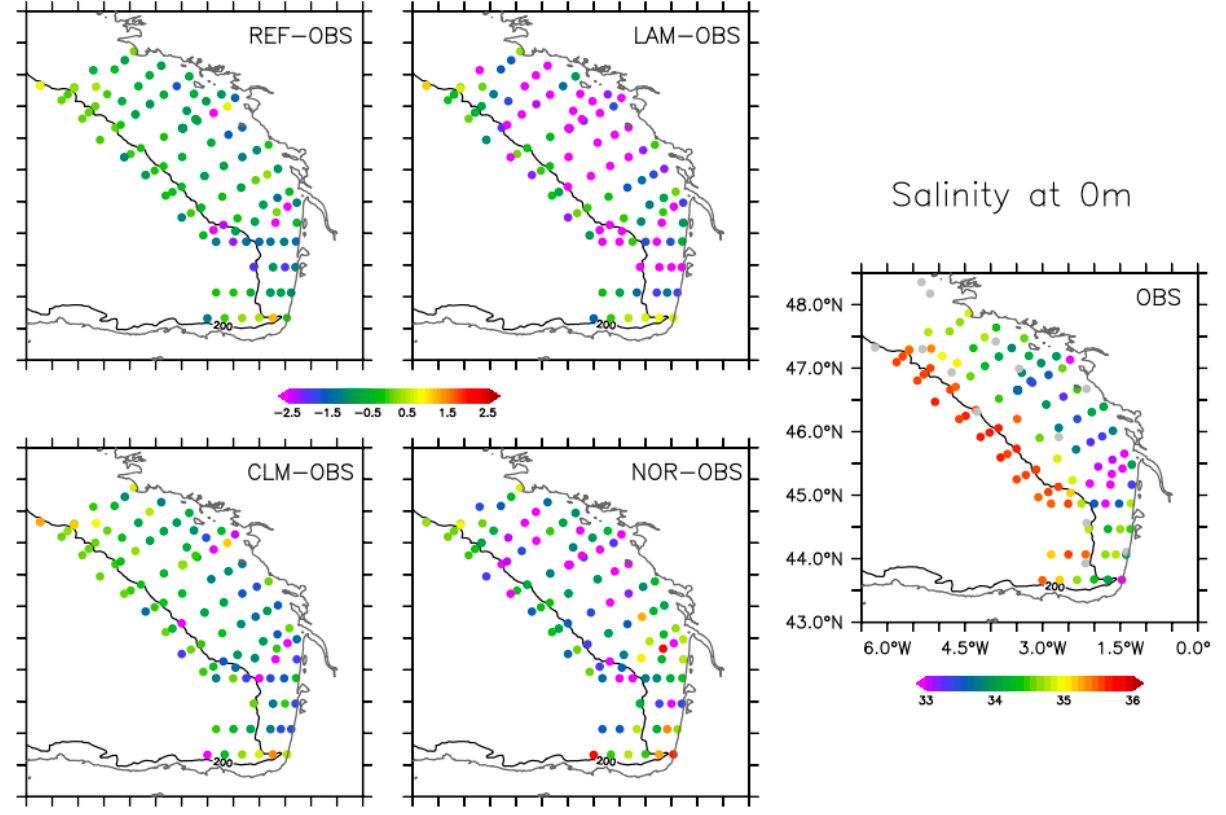
Figure 8. Sea surface salinity (SSS) measured with XBTs from the RECOPESCA campaign for May 2018 in the BISCA area. The right panel shows observed (OBS) salinity, whereas panels on the left show the respective differences between the simulated salinity by each model scenario (i.e., IBI_REF, IBI_LAM, IBI_CLM, IBI_NOR) and the RECOPESCA observa- tions.